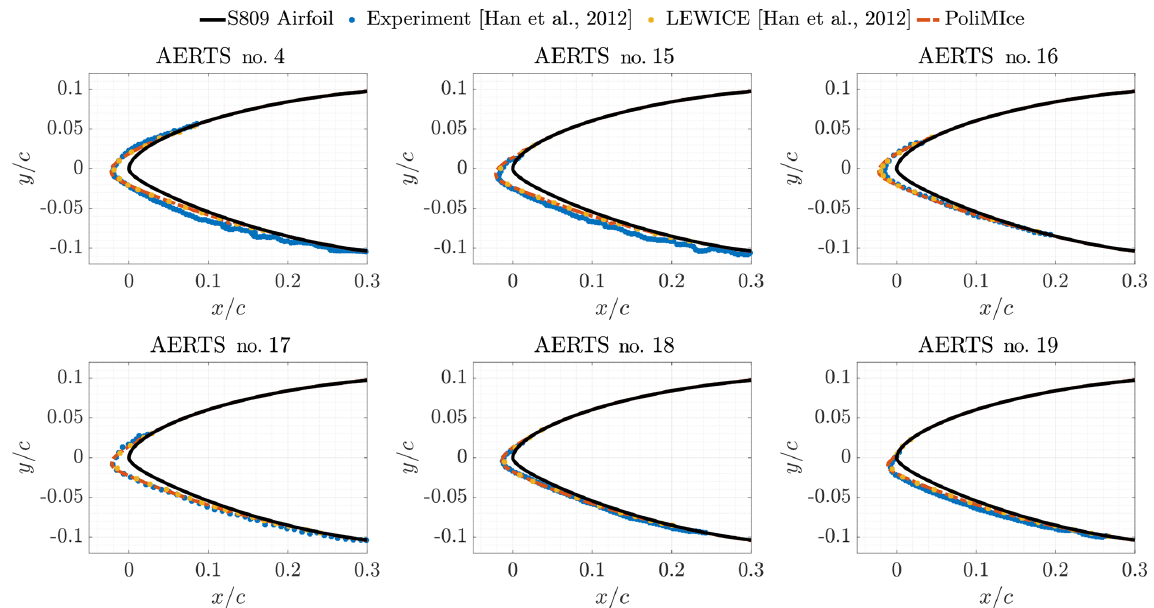
Figure 13. Comparison between PoliMIce simulations, LEWICE simulations, and experiments of AERTS test cases. (cid:107) err β (cid:107) 2 < 3 × 10 − 5